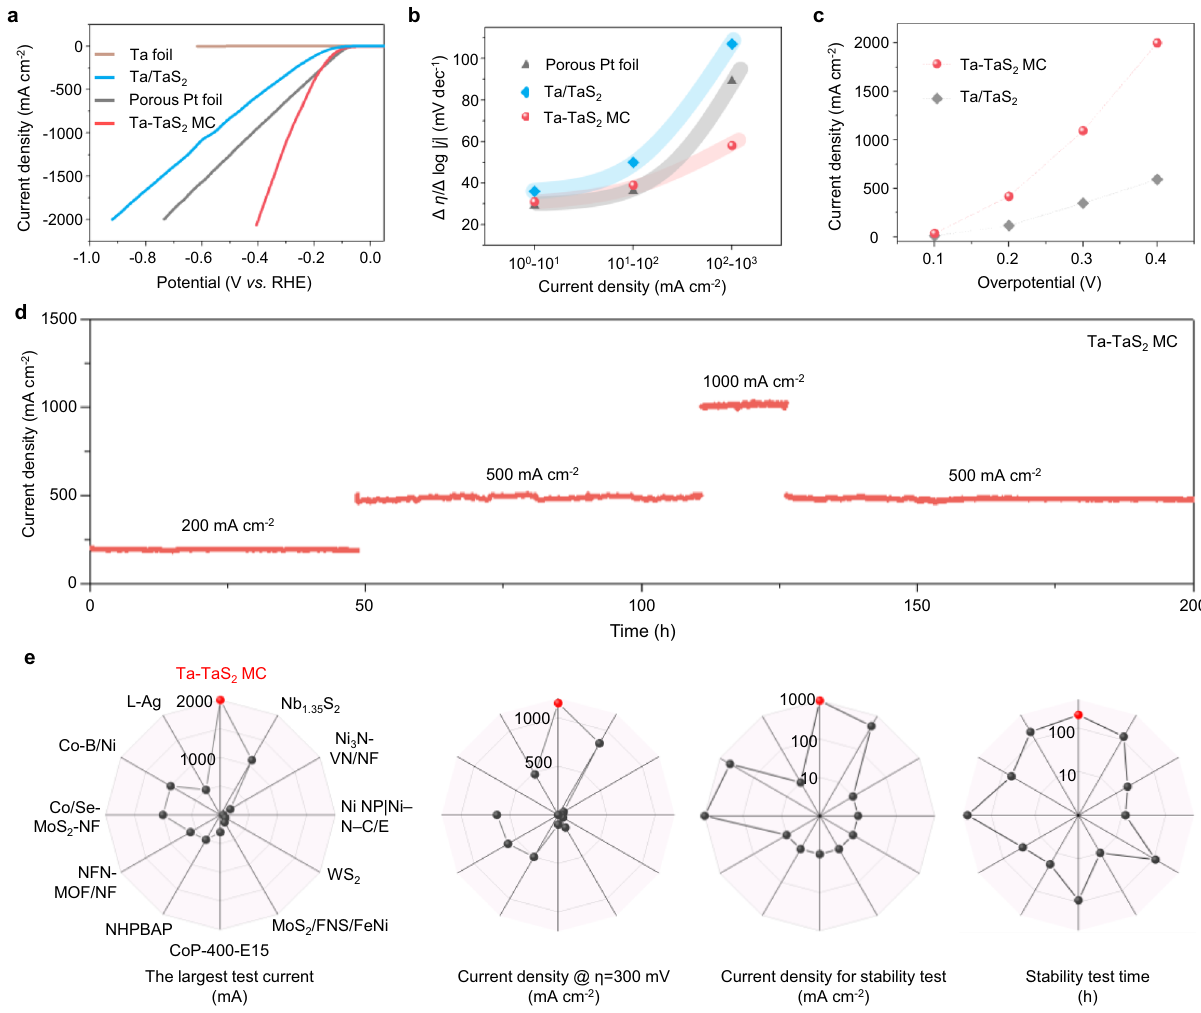
Fig. 4 Large-current-density HER performance of the Ta-TaS 2 MC. a Polarization curves of a Ta foil, Ta-TaS 2 MC, Ta/TaS 2 and a porous Pt foil measured in a 0.5 M H 2 SO 4 electrolyte with a scan rate of 2 mV s − 1 . b Δη / Δ log| j| ratios of the Ta-TaS 2 MC, Ta/TaS 2 and porous Pt foil catalysts at different current densities. c HER activity of the Ta-TaS 2 MC and Ta/TaS 2 . d i-t curves of the Ta-TaS 2 MC at various current densities in a 0.5 M H 2 SO 4 electrolyte. e Comprehensive comparisons of the HER performance of Ta-TaS 2 MC with those reported state-of-the-art catalysts in literature. From left to right: the largest test current; the current density @ η = 300 mV; current density for stability test; stability test